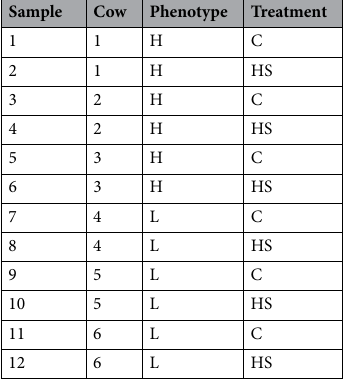
Table 1. Experimental design. This study contained a total of 12 samples from each of three cows immune response phenotyped as high (H) or low (L). A control (C) and heat stressed (HS) sample were generated for each cow, as indicated in the treatment